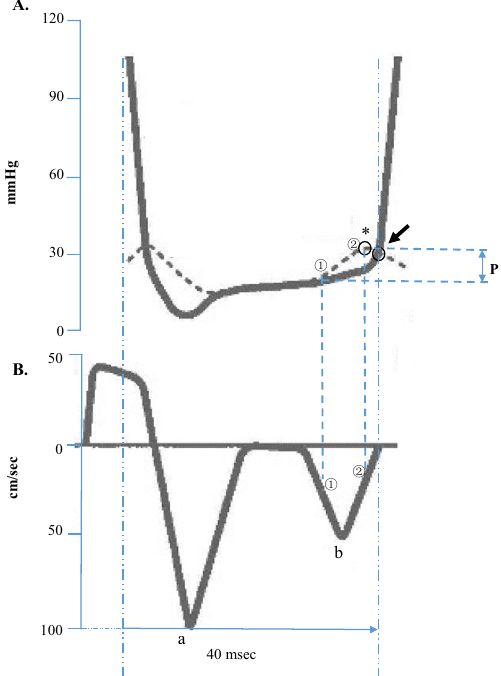
Figure 1. Illustration of the excessive load in the late diastole and the relative muscle relaxation velocity in cardiac ventricles. ( A ) Left ventricle pressure (solid curve) and left atrial pressure (dotted curve) in the ventricular diastolic phase. The areas marked ① and ② represent the rising atrial systolic pressure (kick from the atrium), and * is the maximum atrial systolic pressure. ② was the equilibrium point of atrial pressure to the moment ventricular pressure. The ventricle significantly contracted after the equilibrium point ② . Symbol P indicates the kick amplitude (excessive load amplitude) in the ventricle late diastole phase. ( B ) The ventricle muscle relaxation velocity in each diastole and systole cycle. The handstand peak wave a (the upside down of the peak wave) is the myocardial velocity during early filling, b is myocardial velocity during filling produced by atrial contraction. In handstand peak wave b, the curve between point ① and ② show the relaxation velocity response to ① and ② . The ventricular muscle velocity was significantly reduced because of excessive load from the kick. In takotsubo ventricle, massive volume filling interrupted the normal pattern of peak waves a and b. Myocardium was extremely overlengthened. The images originated from Zile and Brutsaert 16 and were modified. All rights